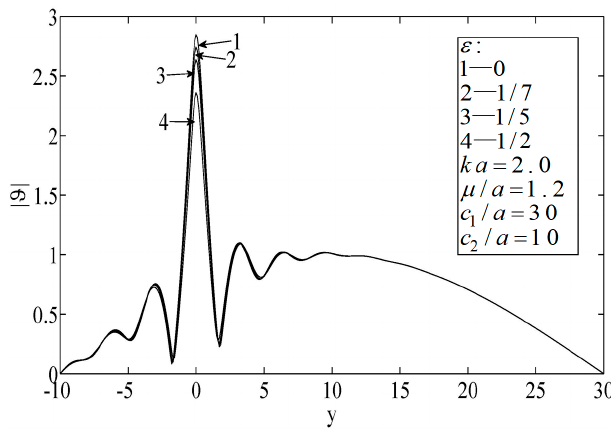
Figure 8. Temperature on the surfaces of the block.